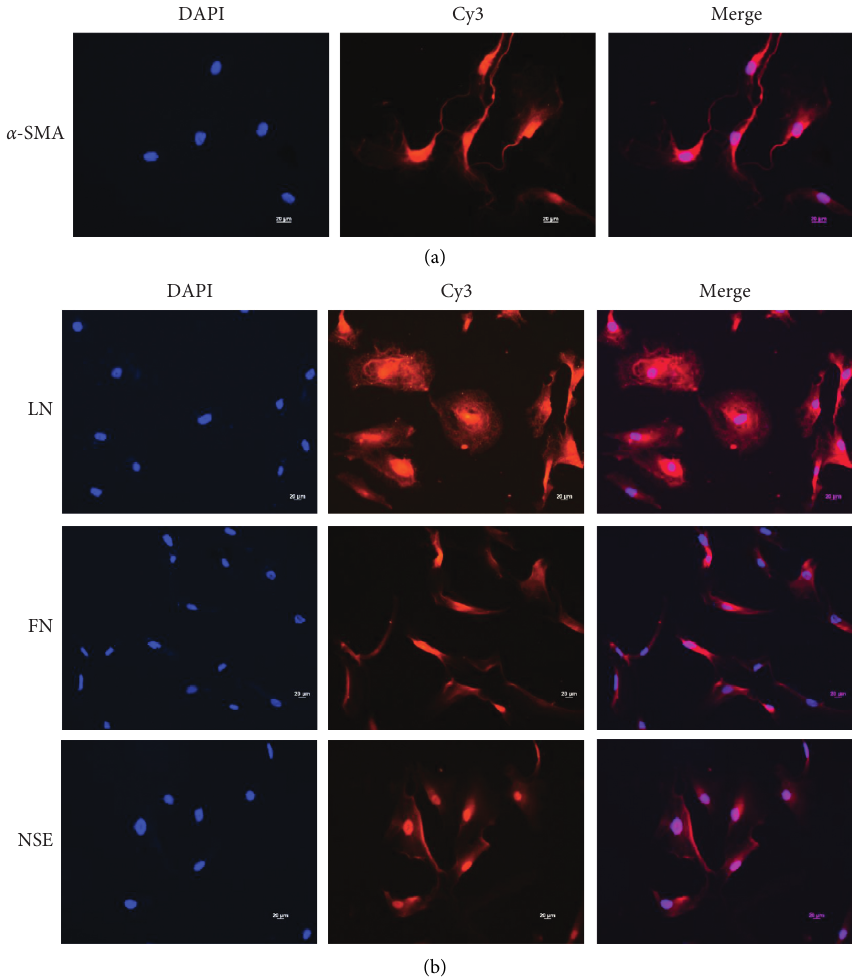
Figure 2: Identification of primary cultured cynomolgus monkey ciliary muscle cells and trabecular meshwork cells by immunofluo- rescence ( × 200). (a) The primary CM cells stained positively against α -SMA. (b) The primary TM cells stained positively against LN/FN/